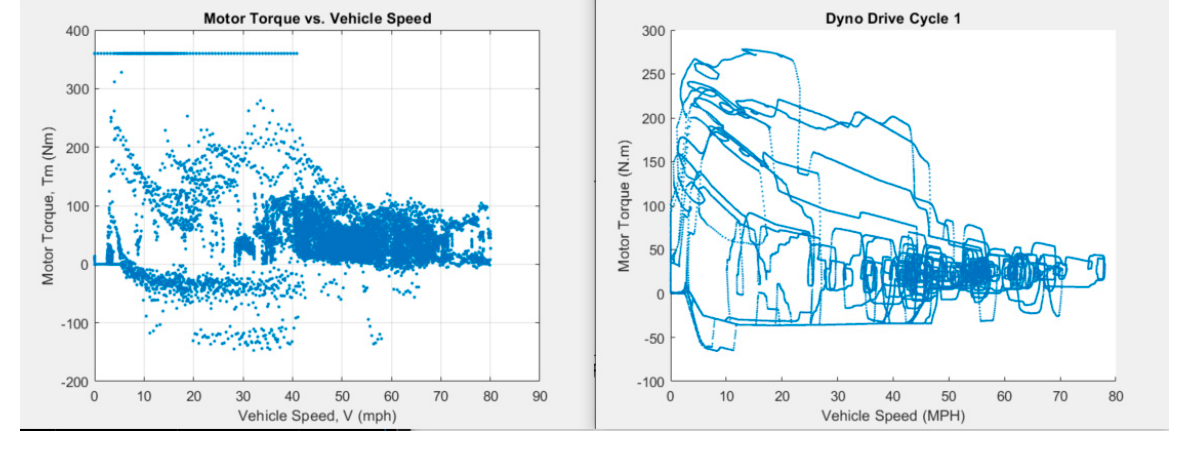
Figure 24. Motor power vs. speed for MCT drive cycle simulation.